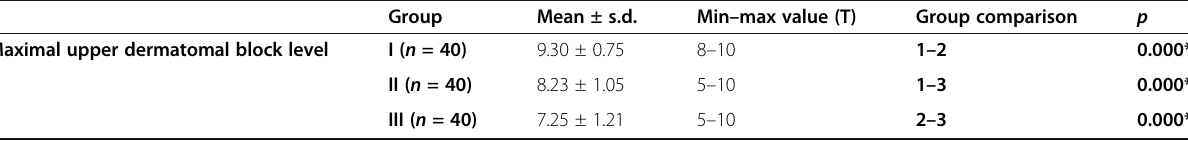
Table 4 Maximal upper dermatomal block level (T)